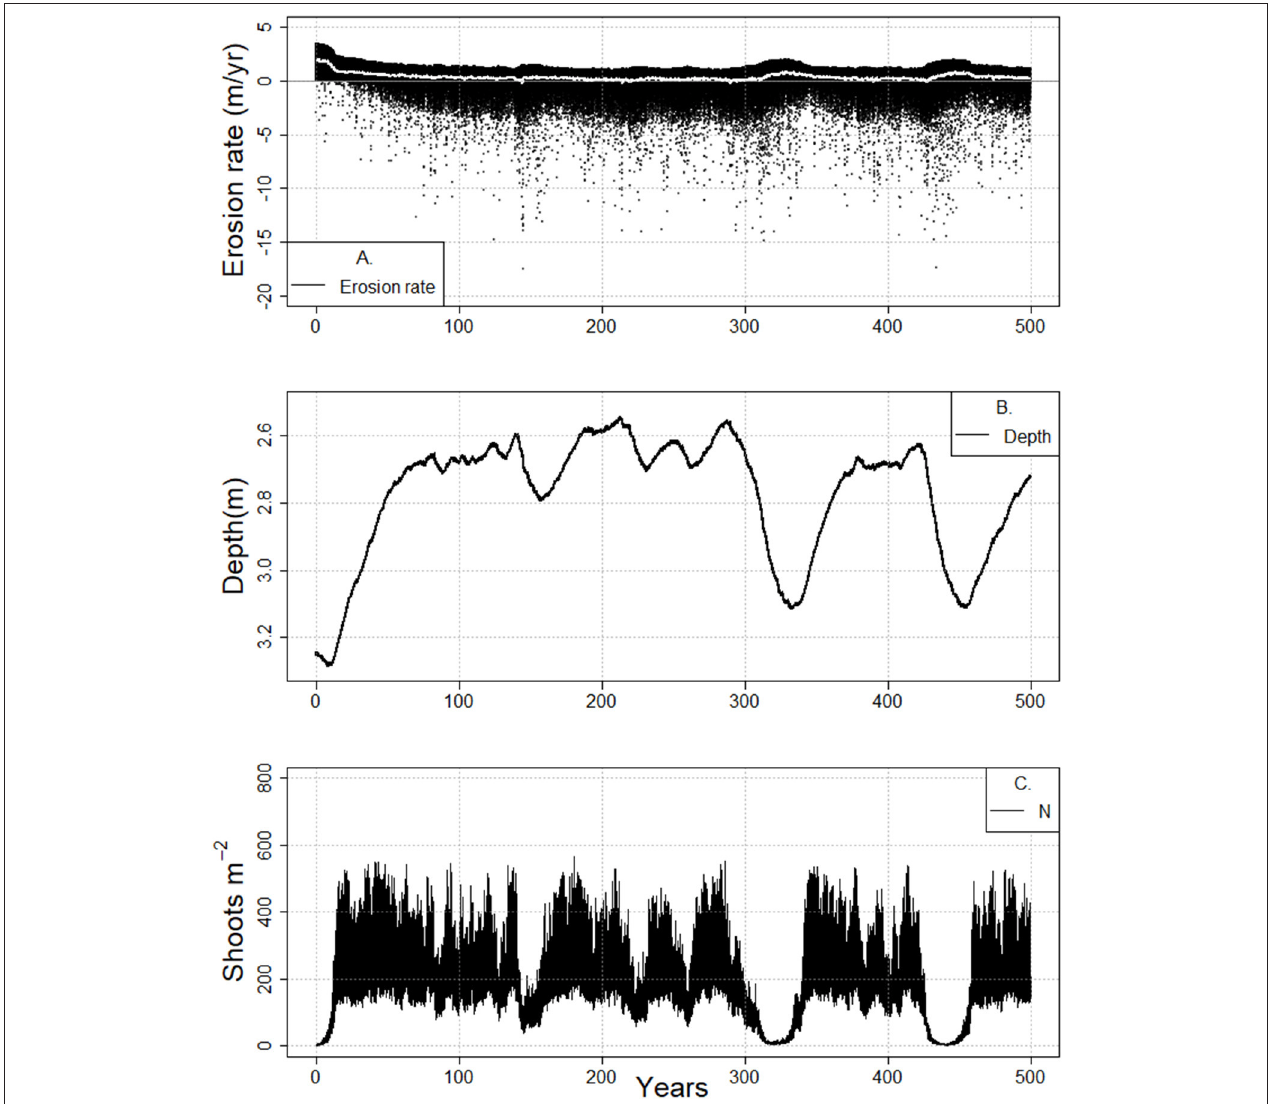
FIGURE 9 | Cyclical meadow behavior and concurrent changes in tidal flat erosion rate (A), tidal flat depth (B), and shoot density (C) during the 500-year-long model runs (RSLR 4mm year − 1 , Co = 30 mg/L, b f = 3.0km) for a prograding marsh